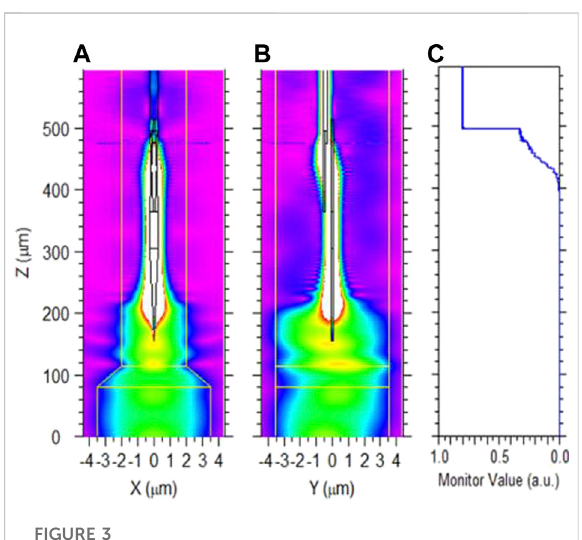
FIGURE 3 Simulated optical fi eld distribution in the converter at 1,550 nm. (A) : Top view; (B) : Lateral view; (C) : monitored optical power intheconverter(blue line:thepowerinthec-Si overlapped